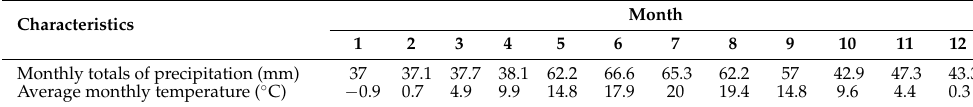
Figure 2. Distribution of flows during the year. Table 1. The basic climatic characteristics of the area investigated.